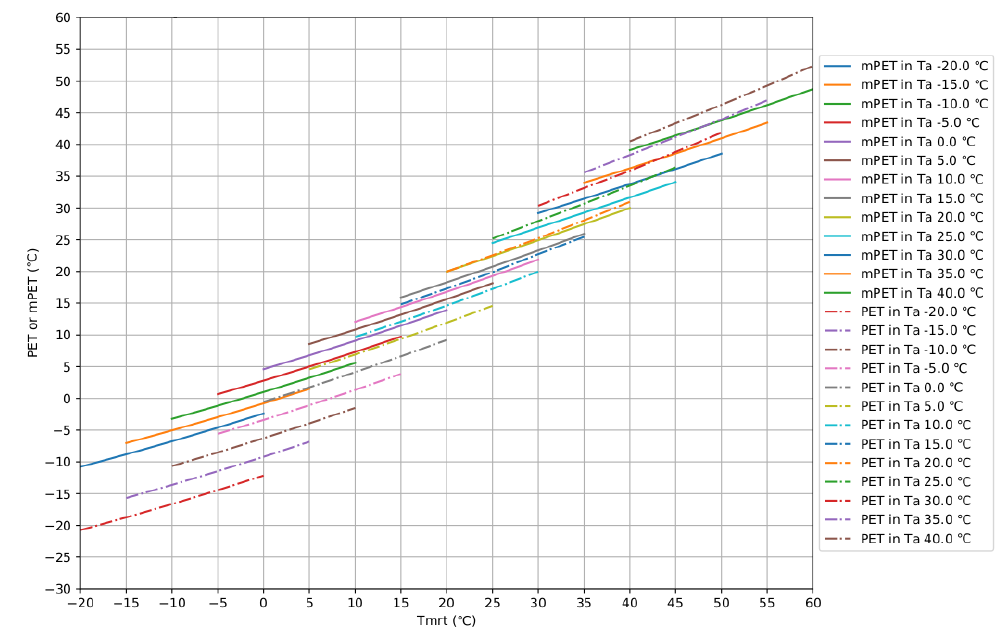
Figure 8. The comparison of PET and mPET in different T a and T mrt